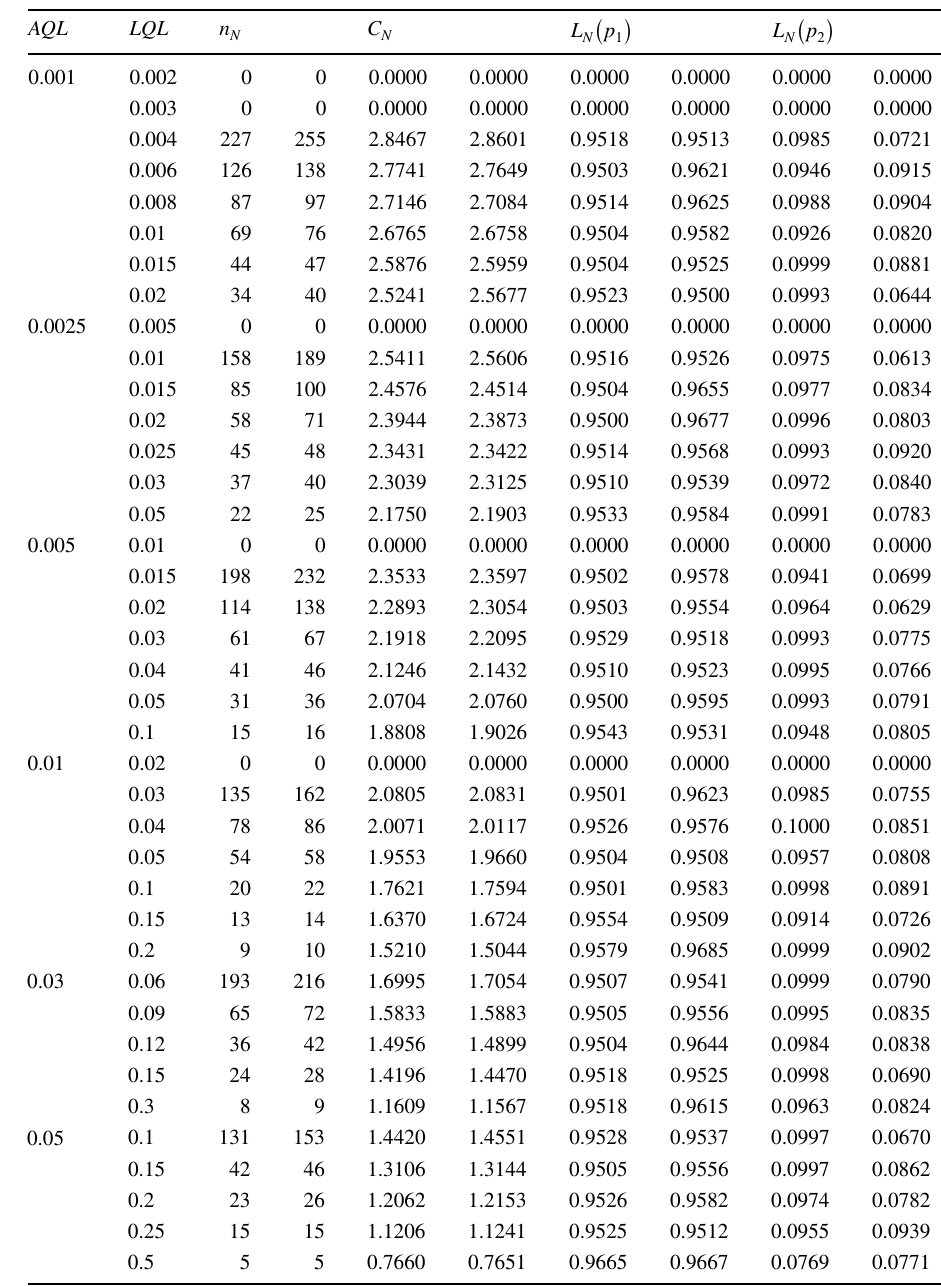
Table 6 Plan parameters for the proposed plan, when 𝜎 Y N is = unknown and 𝜌 X N Y N